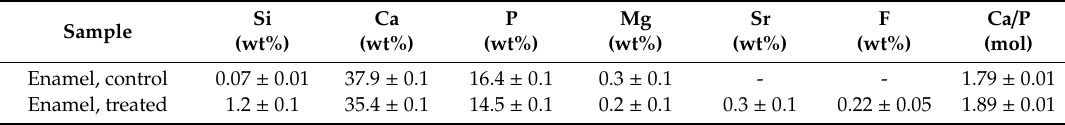
Table 3. Semiquantitative energy-dispersive X-ray spectroscopy (EDX) compositional analysis of enamel surface